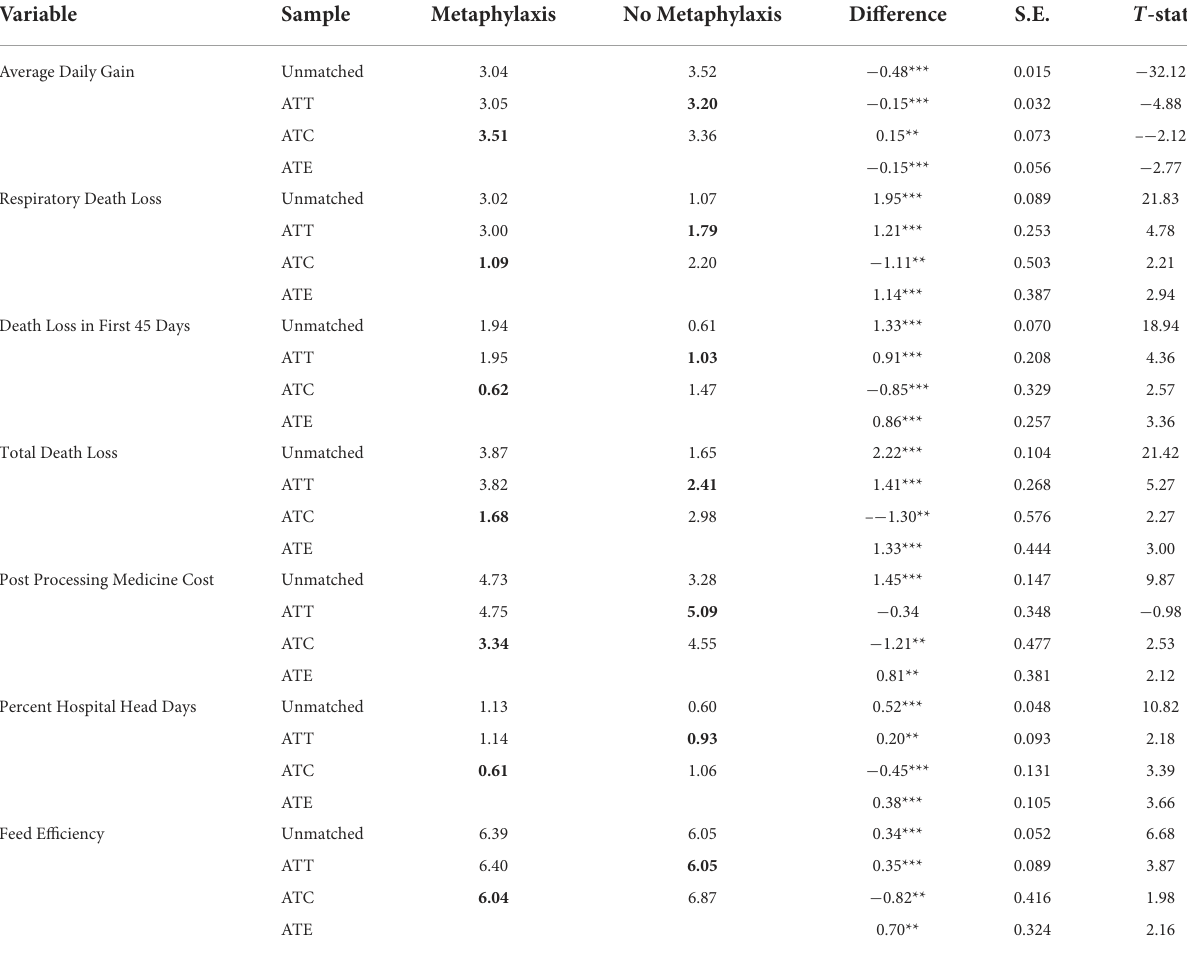
TABLE 4 Estimated effects of cattle being given metaphylaxis treatments at feedlot arrival using propensity score matching. Variable